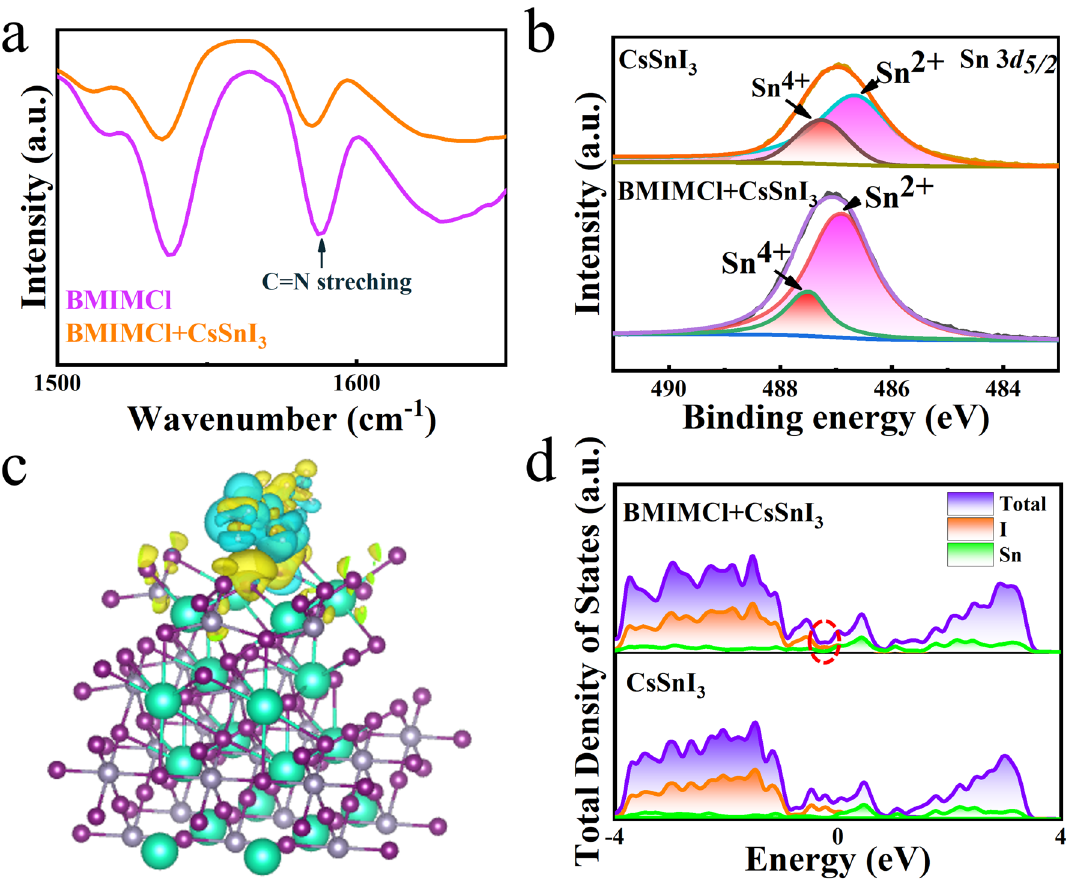
Fig. 3 a FTIR spectra of the BMIMCl and CsSnI 3 with BMIMCl at the wavenumber of 1500–1650 cm −1 . b XPS spectra of Sn 3 d of the CsSnI 3 without and with BMIMCl. c Differential charge density of the BMIMCl on CsSnI 3 . d Total density of state of the perovskite and the BMIMCl passivated